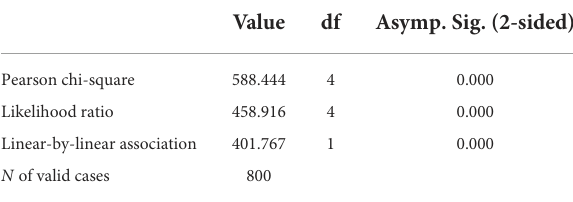
TABLE 6 Chi-square test between the dimension of empathy and satisfaction for the quality of services in public